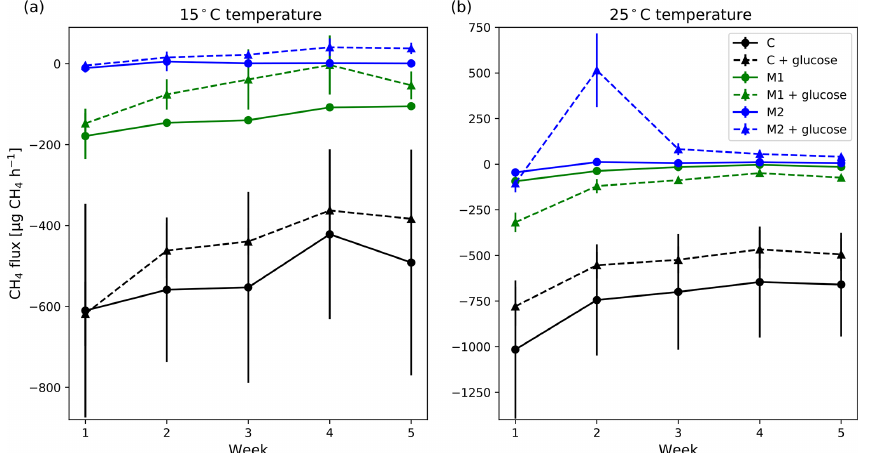
Figure 9. Weekly mean CH 4 flux measured at 15 ◦ C (a) and 25 ◦ C (b) without (solid lines) and with (dashed lines) added glucose on different moisture levels (black: control; green: low added moisture; blue: high added moisture). The error bars show the standard error of the mean ( n = 3). Positive flux values indicate net emission and negative values indicate net